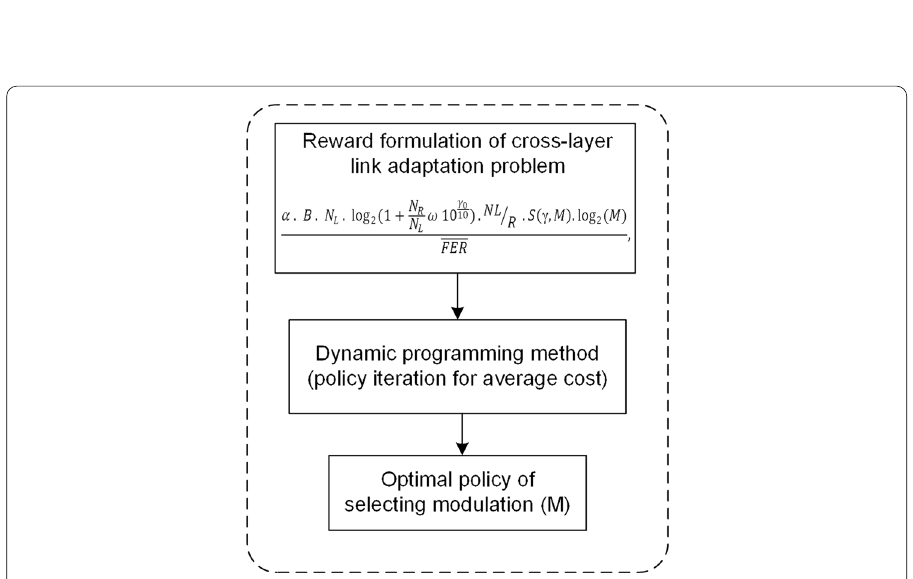
Fig. 5 Dynamic programming‑based MDP algorithm for optimal policy resulted by agent